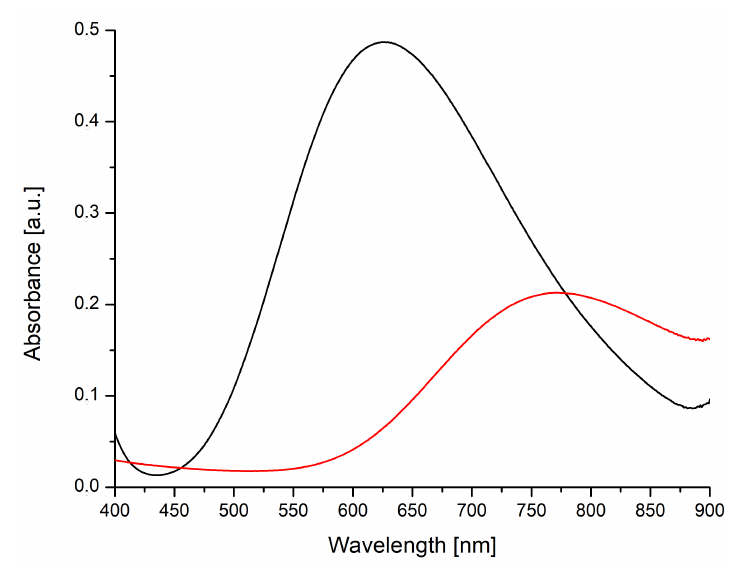
Figure 9. Vis spectra of 2b (black) and copper(II)-acetate (red); c = 1 mmolL − 1 .